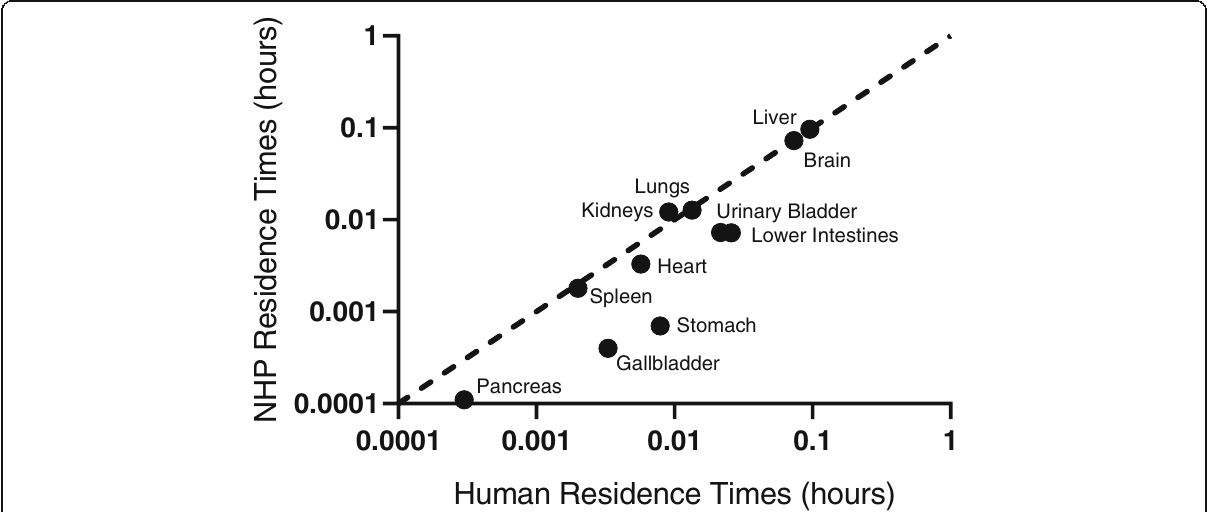
Fig. 3 Comparison of residence times for 11 organs of humans and rhesus monkey ( Macaca mulatta ) non-human primates (NHP), on a log-log plot